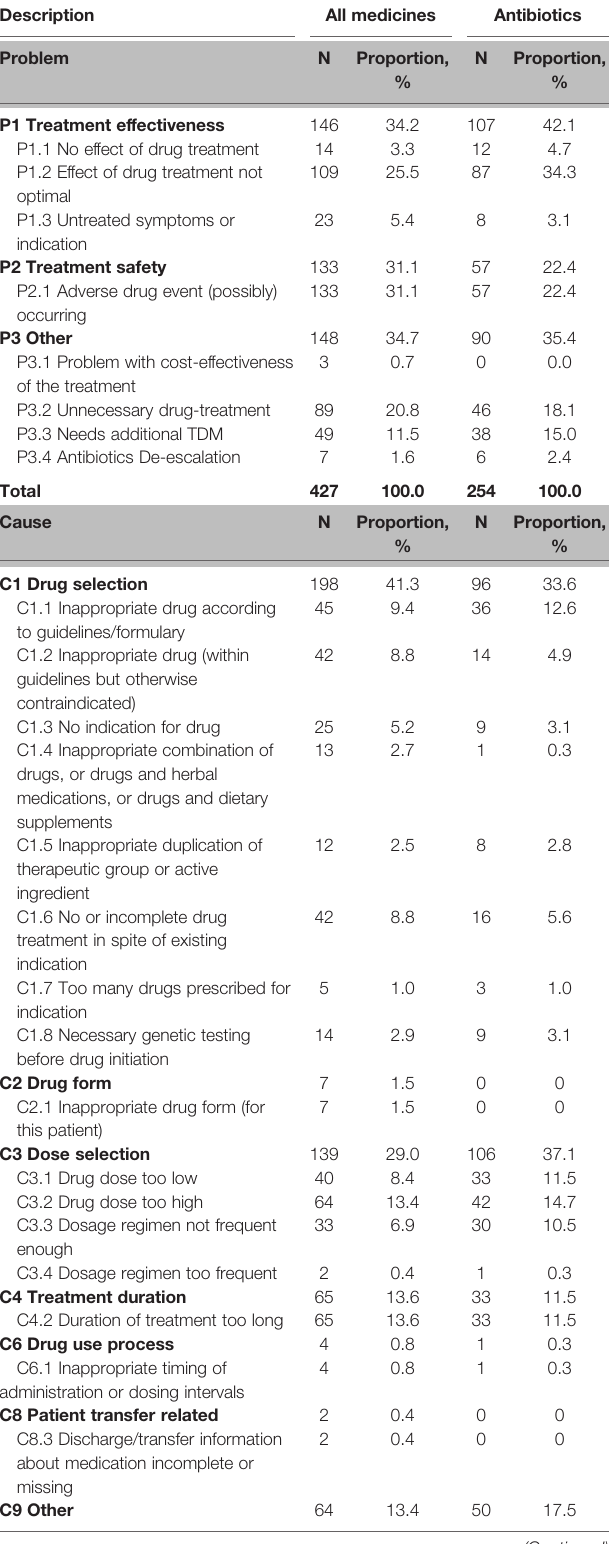
TABLE 2 | Number of drug-related problems and causes of all medicines and antibiotics during pharmacy